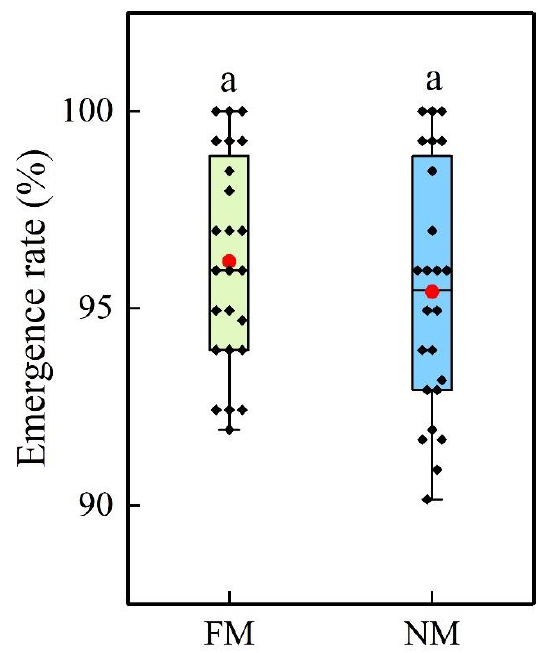
Figure 1. Comparison of emergence rates of film (FM) and no-film (NM) planting. The boxes repre- sent the interquartile ranges (IQR), the whiskers indicate reasonable sample borders (Tukey tests), the horizontal line in each box indicates the median, and the red dot indicates the mean. Different lowercase letters indicate significant differences ( p < 0.05, n = 24).